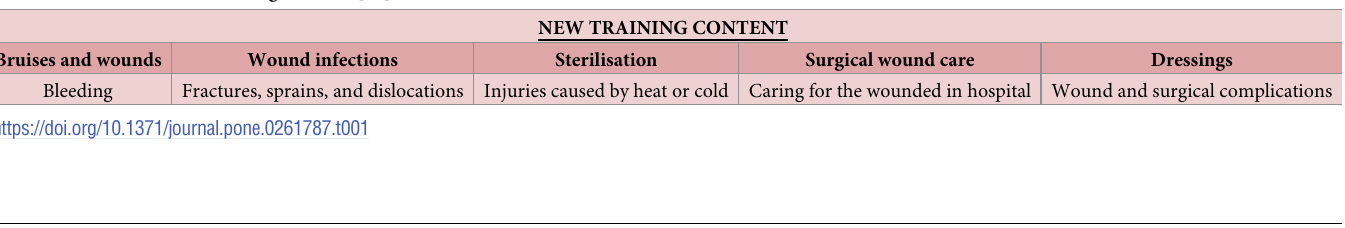
Table 1. Content of nurse training manuals